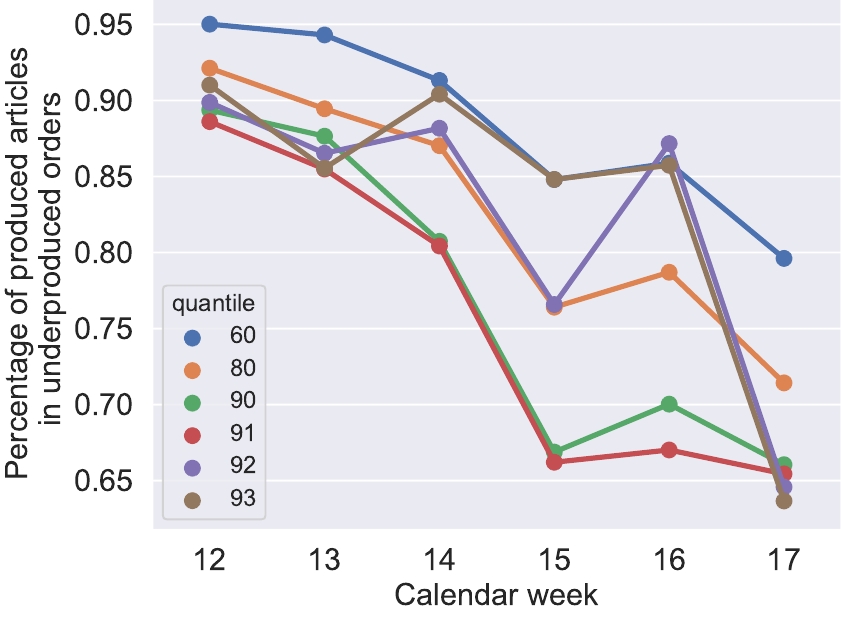
Figure 18. Average percentage of underproduction in orders producing too few items due to scrap.